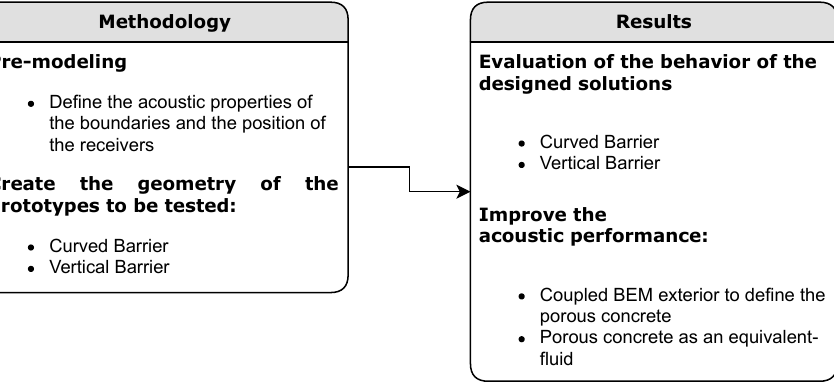
Figure 10. Schematic representation of the methodology and results.